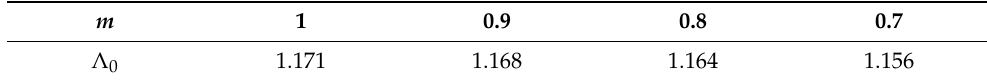
Table 1. Dependence of Λ u on m at χ =